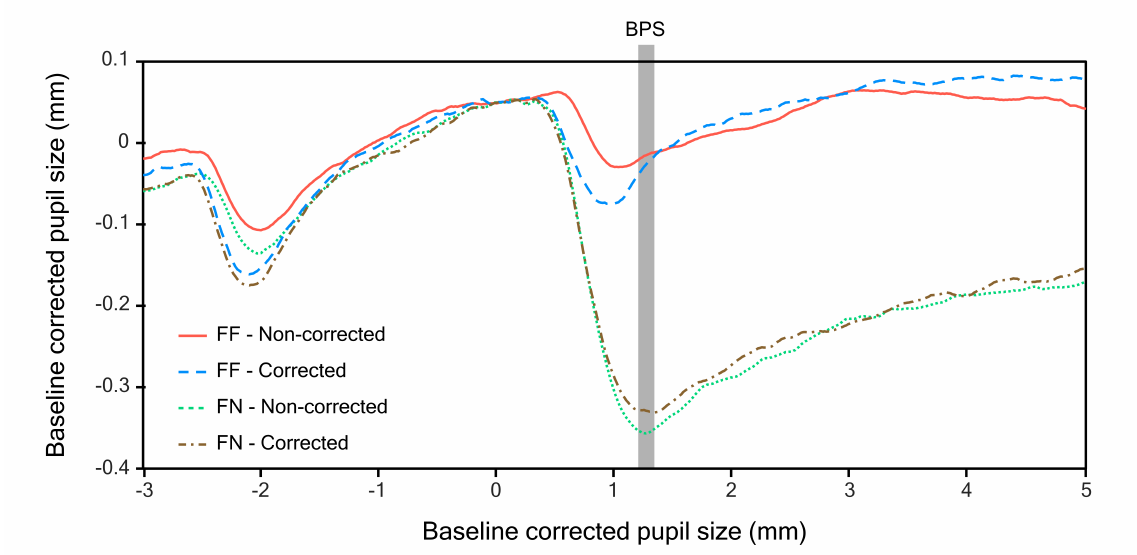
Figure 3. Grand mean pupil traces of experiment 1. At -3 s the target first appeared at a far position. At 0 s the target jumped to the second location. The period from 0 to 0.1 s, marked by the grey box, indicates the time period over which baseline pupil size (BPS) was